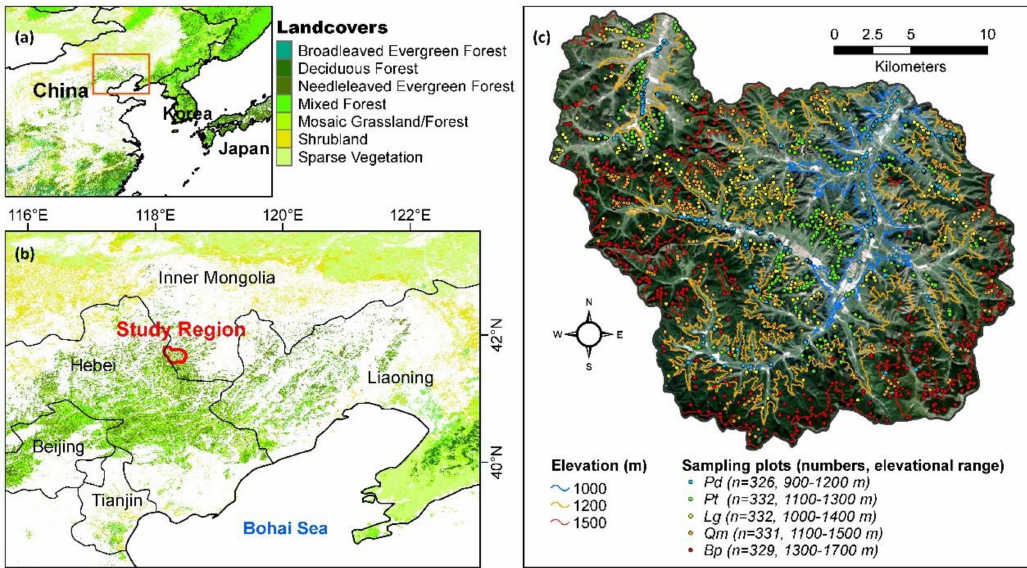
Figure 1. The geographical location map of the study region and major vegetation cover types in background ( a , b ), and the sampling sites of five tree species, including evergreen coniferous forest dominated by Pinus tabulaeformis (Pt), deciduous coniferous forest dominated by Larix gmelinii (Lg), and three deciduous broadleaved forest dominated by Quercus mongolica (Qm), Betula platyphylla (Bp), and Populus davidiana (Pd), (n = 1650, approximately 330 for each tree species) overlaid on a GF-1 image (22 August 2017) in background ( c